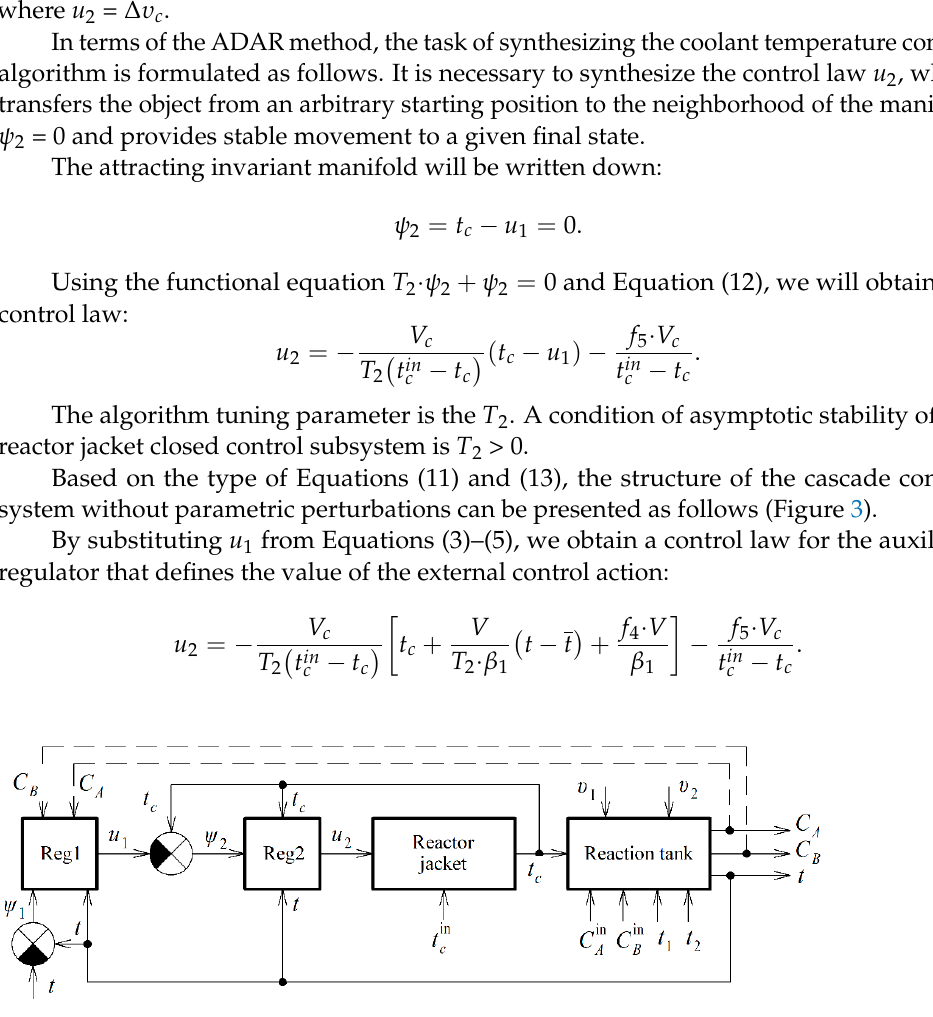
Figure 3. Structure of the cascade reactor thermal control system: Reg1—main controller; Reg2— auxiliary control system.